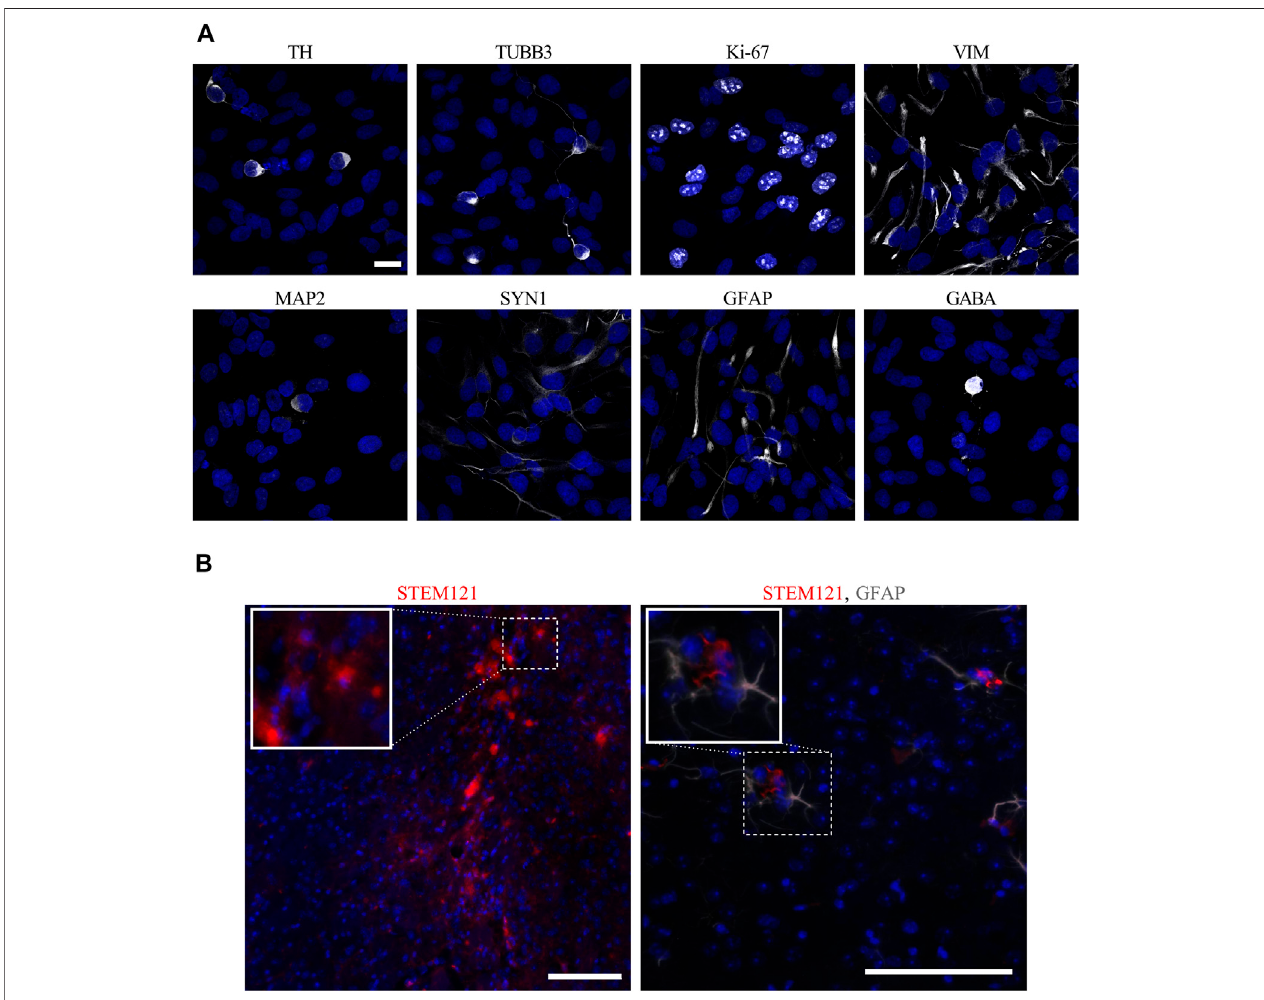
FIGURE 3 | In vitro and in vivo images of hVM1 clone 32 cell markers. (A) After 7 days of differentiation in vitro , hVM1 clone 32 cells express a range of proteins including TH, TUBB3, Ki-67, VIM, MAP2, SYN1, GFAP, and GABA (all in white). Nuclei were stained with DAPI (blue). Scale bar (cid:1) 20 μ m. (B) Surviving transplanted hNSCsintheStr4 monthspost-transplantasmarkedbySTEM121inredwhichstainshuman-speci fi ccytoplasm (left) ,andastrocytesasmarkedbyGFAPingreynear the transplanted cells (right) . Nuclei were stained with DAPI (blue). Scale bars (cid:1) 100 μ